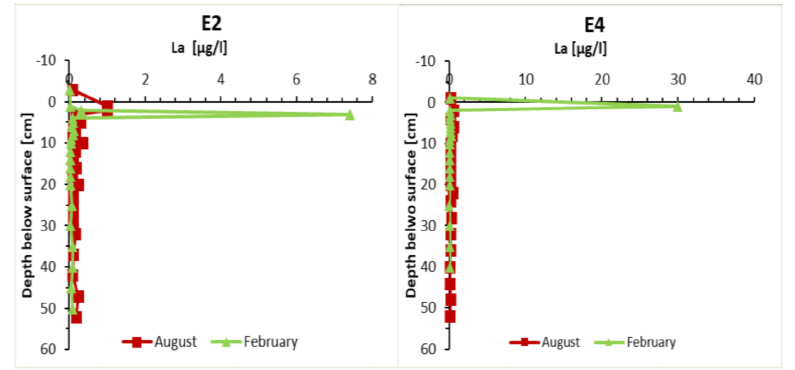
Figure 11. Lanthanum (La) pore water profiles at locations E2 and E4 determined in August 2018 and February